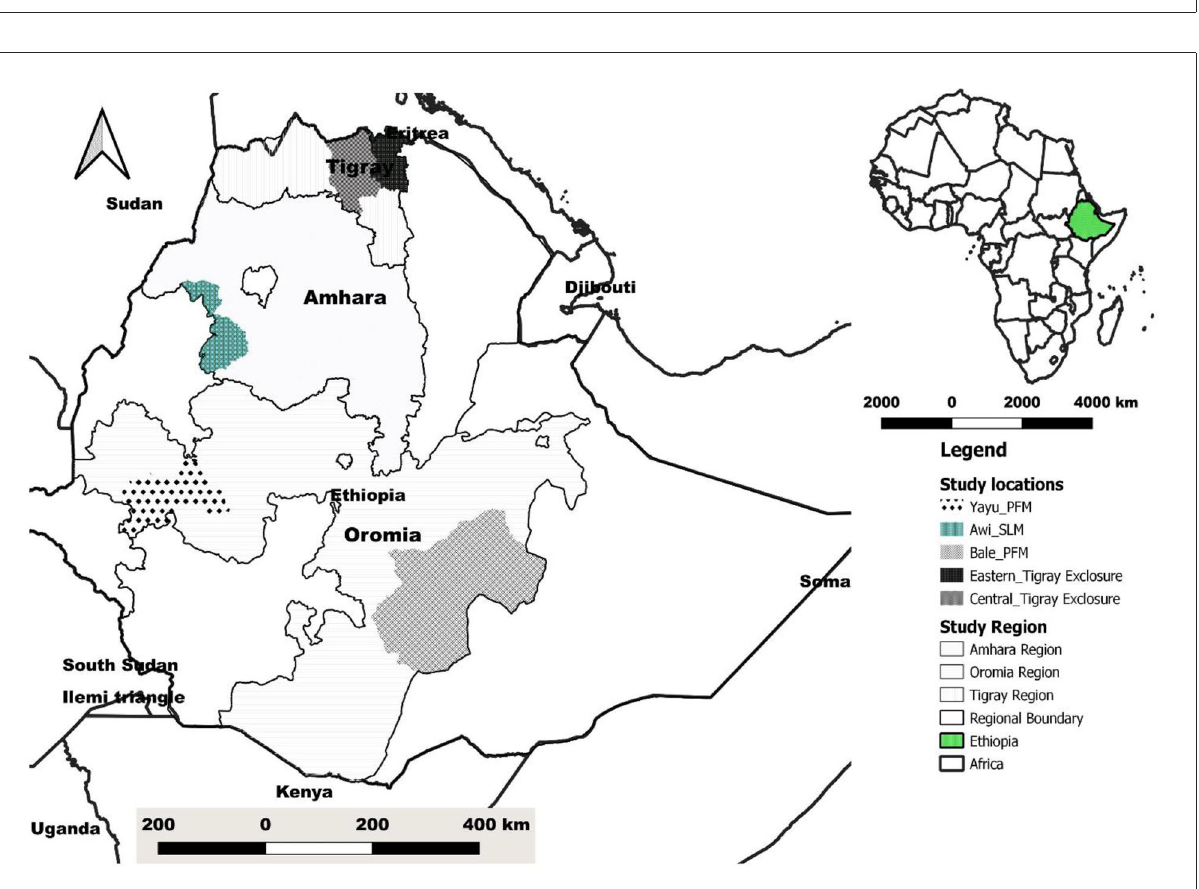
After properly labeling each subset of Landsat scenes with better accuracy, all the subsets were merged and used for change analysis. Field visits were carried out before and after satellite